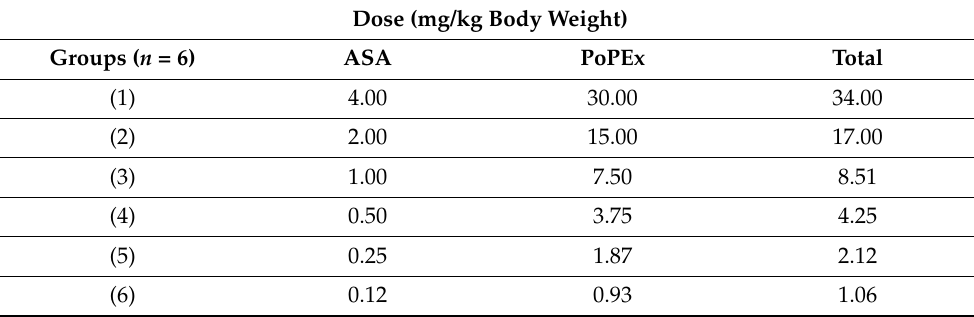
Table 5. ED 30 used of the interaction between ASA and PoPEx before administration of 2% formalin. Dose (mg/kg Body Weight) Groups ( n = 6)